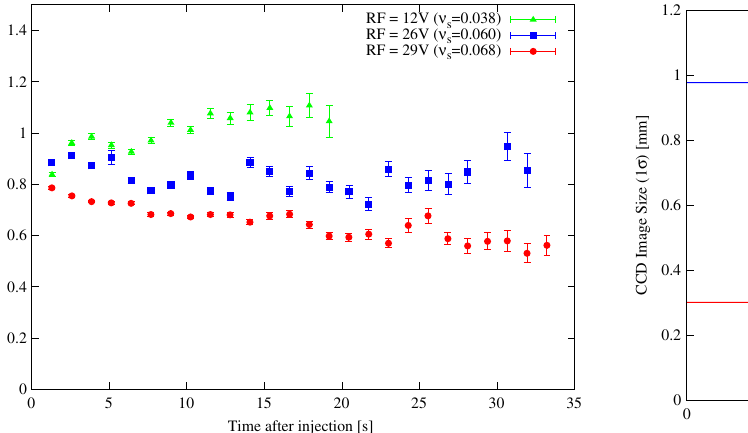
FIG. 11. Synchrotron-tune dependence of the horizontal beam size measured at 30 sec after injection by the CCD camera. The longitudinal momentum spread measured with the PAT 1 sec after injection is plotted in red triangles as a function of the synchrotron tune. The betatron tunes are fixed at ð (cid:1) x ; (cid:1) y Þ ¼ ð 2 : 068 ; 1 : 105 Þ in this experiment. On the coupling resonance given by Eq. (1), the horizontal temperature goes down to (cid:4) 200 K , and the longitudinal temperature goes up to 21 K from 14 K by the heat transfer from the horizontal degree of freedom. Note that, because of the limited laser spot size ( (cid:4) 1 mm ), the observed beam-image size may be underesti- mated in the region at off resonance.